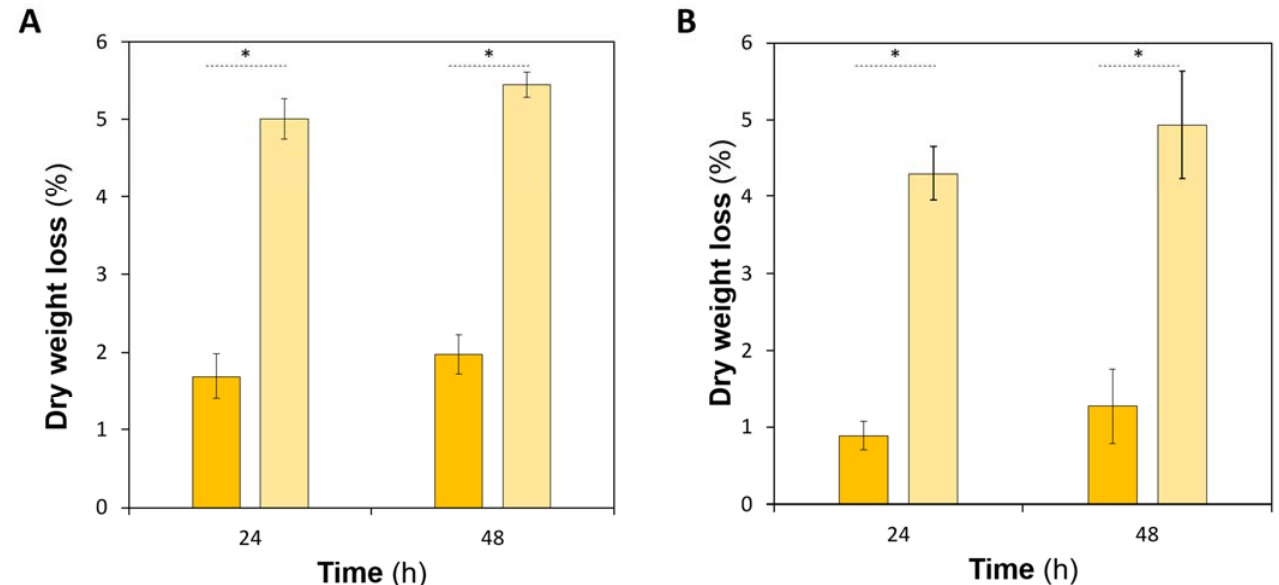
Figure 3. Degradation values for hydrogels of formulation CS ( A ) and C ( B ), in PBS (dark yellow) and in PECF containing lysozyme (light yellow). Error bars correspond to ± standard deviations (n = 4). Statistical analysis was performed using the Student t-test or Wilcoxon signed-rank test, with significance set at * p < 0.001.